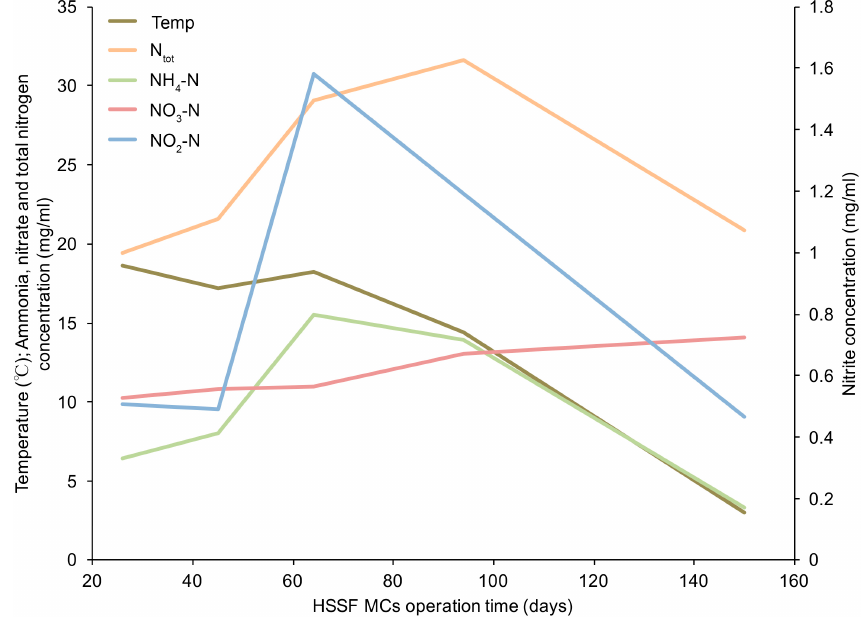
Figure A2. Temperature and temporal dynamics of different nitrogen forms in